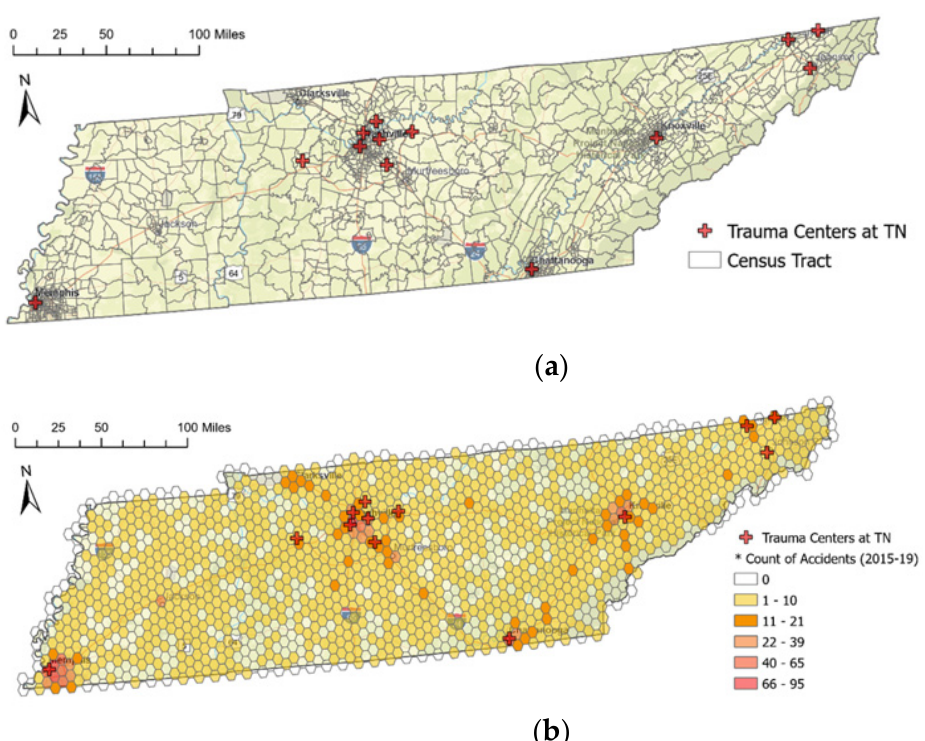
Figure 3. Study area of the state of Tennessee with the location of trauma centers, and data processing of hexagonal tessellation. ( a ) Locations of trauma centers and census tract in Tennessee, 2019; ( b ) Tessellation by hexagonal grids and vehicle accidents distribution.